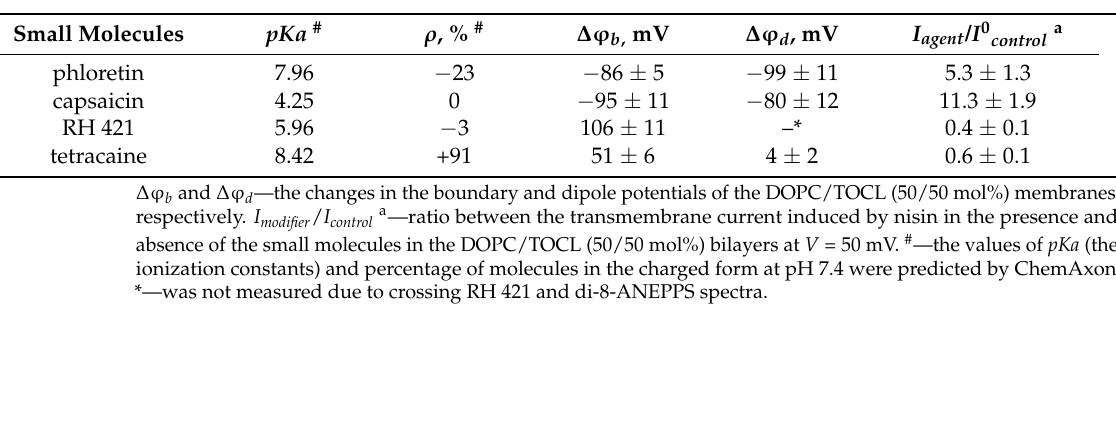
Table 2. The effects of the small molecules on the electrical properties of DOPC/TOCL (50/50 mol%) membranes and nisin-induced transmembrane